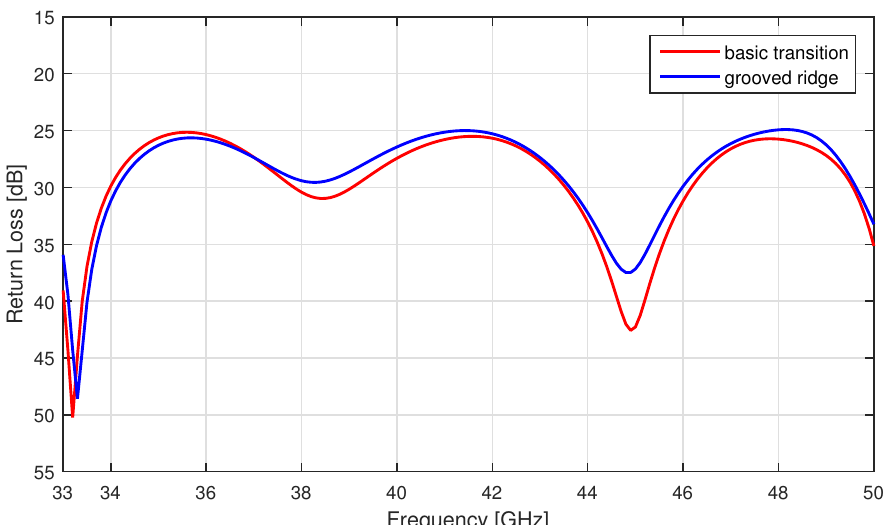
Figure 12. Return loss comparison: the grooved short displayed in Figure 11 (blue line) does not introduce a relevant variation with respect to the return loss of the initial design shown in Figure 7.